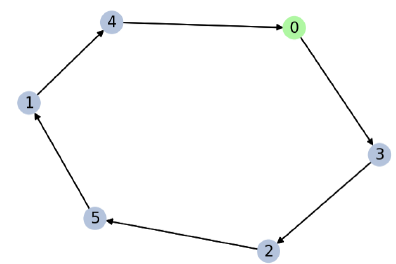
Figure 1. Example of a TSP solution with six different cities. It begins at node 0, and the arrows indicate the order in which the towns will be